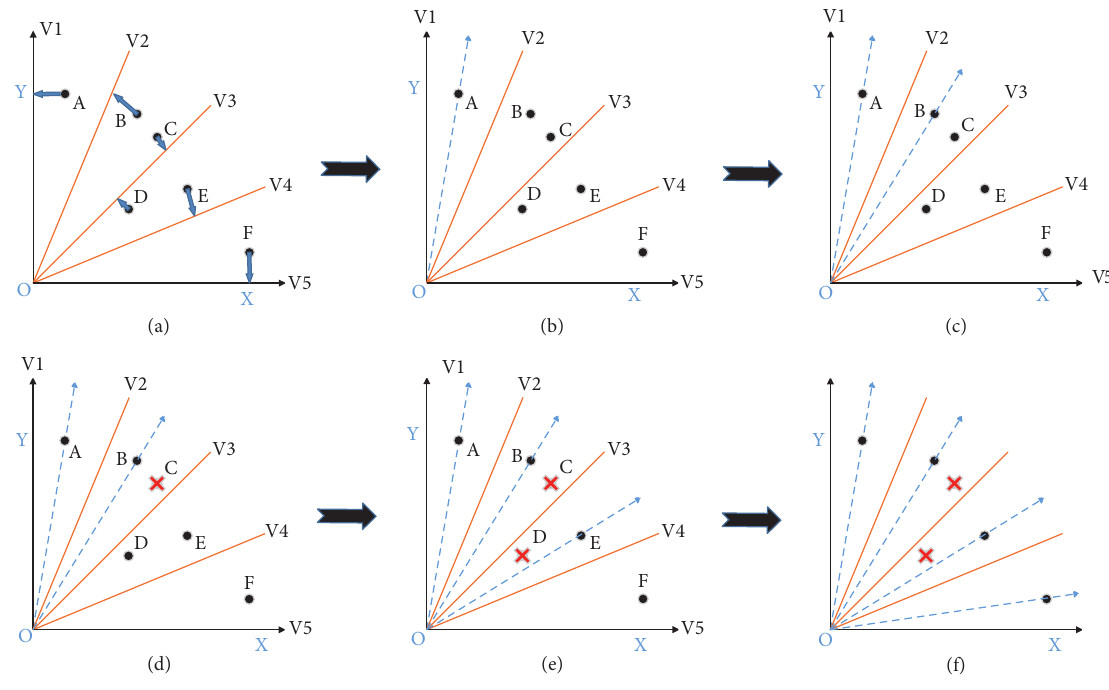
Figure 4: An example of the reference vector adjustment